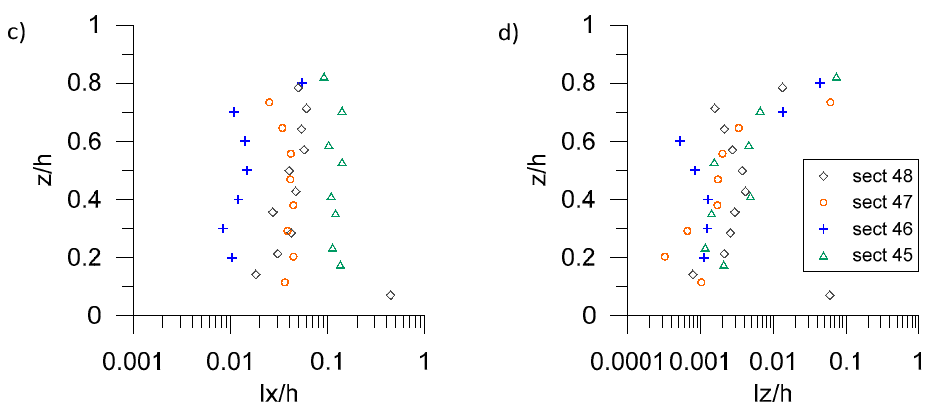
Figure 5. Test P: time-averaged horizontal ( a ) and vertical ( b ) integral length scales; time-averaged horizontal ( c ) and vertical ( d ) turbulent length scales.